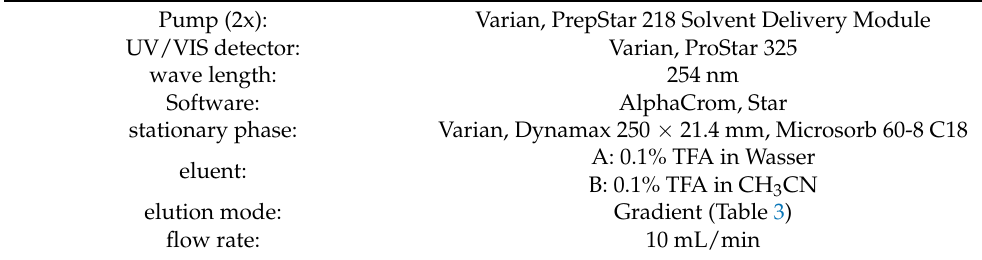
Table 2. Components and parameters of the semi-preparative HPLC system.